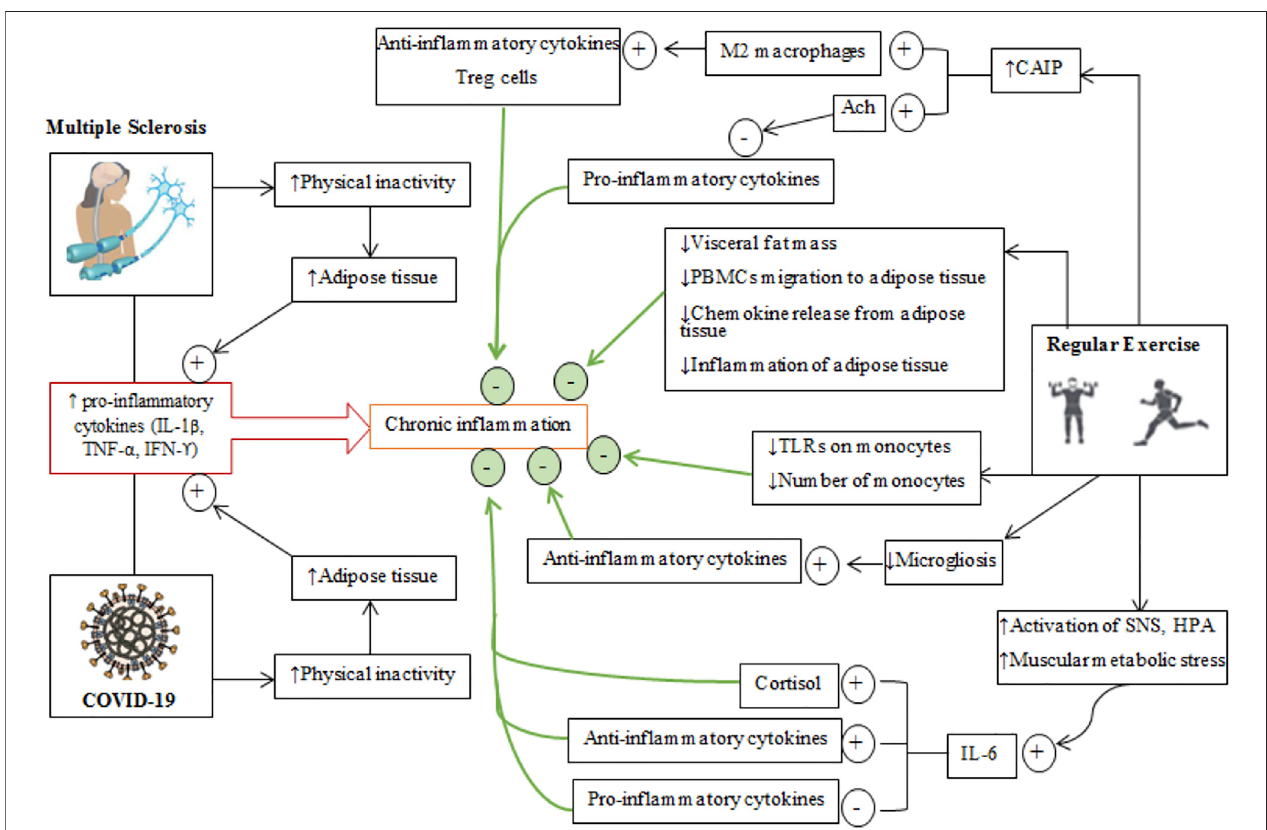
FIGURE4 | Schematic depiction ofthe effects ofregular exercise on in fl ammatoryconditionsin multiple sclerosisand COVID-19diseases. The generally common and different pathways through which MS and COVID-19 cause an in fl ammatory condition are shown on the left while isolated effects of regular exercise that regulate/ modulatein fl ammationareshown on theright. Plus(+)signsrepresenttheincremental effects ofexercise, while minus ( − )signsrepresentdecreasedeffects ofexercise. The cumulative effects of regular exercise are shown by the thick green arrows and green circles. Treg cells, T regulatory cells; PBMCs, peripheral blood mononuclear cell; CAIP, cholinergic anti-in fl ammatory pathway; SNS, sympathetic nervous system; ACh, acetyl choline; TLRs, toll-like receptors.